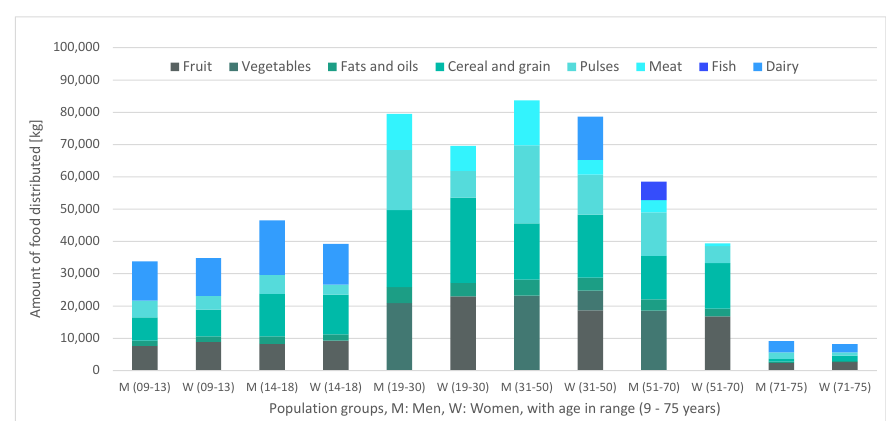
Figure 2. Amounts of distributed food, per food group.